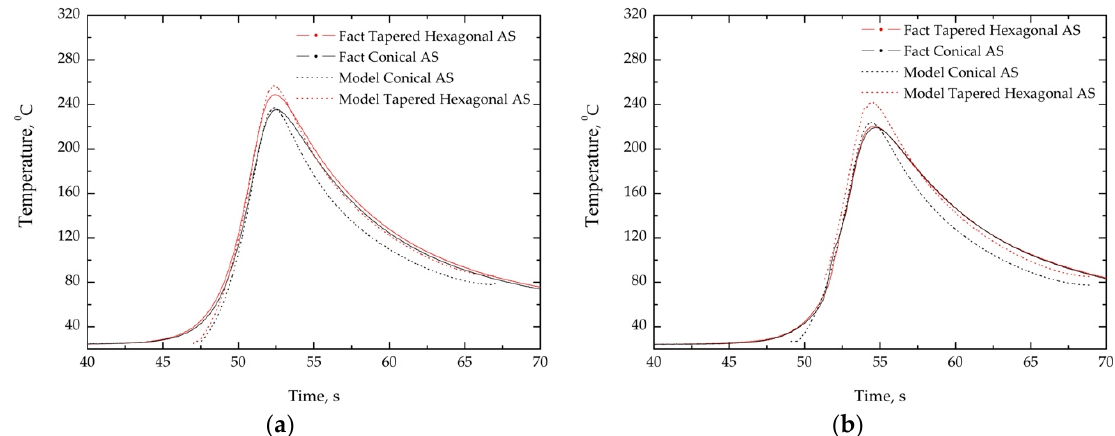
Figure 5. The measured and calculated thermocycles during FSW using cylindrical and tapered hexagonal probe on ( a ) advancing side (AS); and on ( b ) retreating side (RS).